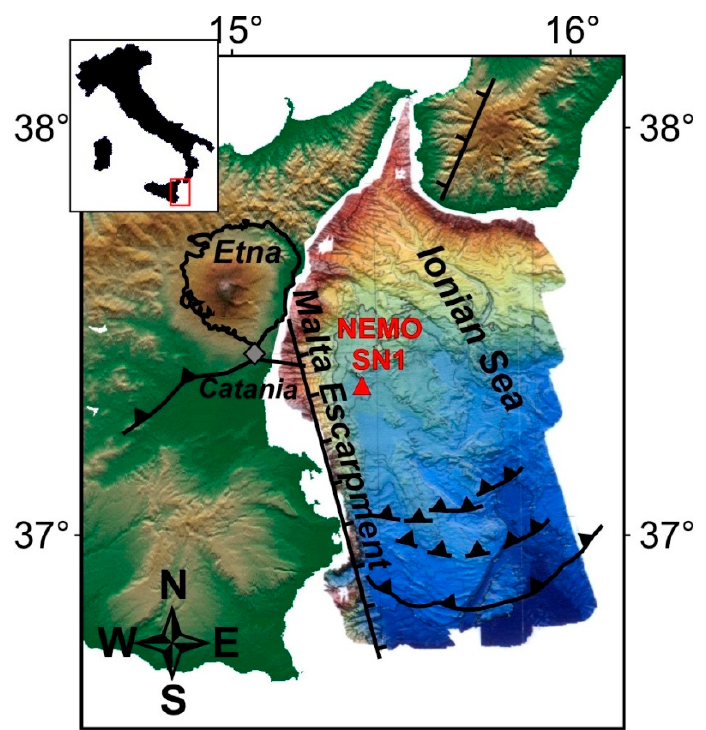
Figure 1. Western Ionian Sea multibeam map (redrawn from Marani et al. [39]). The red triangle indicates the location of the NEMO-SN1 seafloor observatory. Simplified geological structures are also reported (data obtained from previous studies [39–41]), where continuous lines with ticks refer to extensional and strike-slip faults, and lines with black triangles are thrusts and reverse faults (modified from Sgroi et al. [36]).